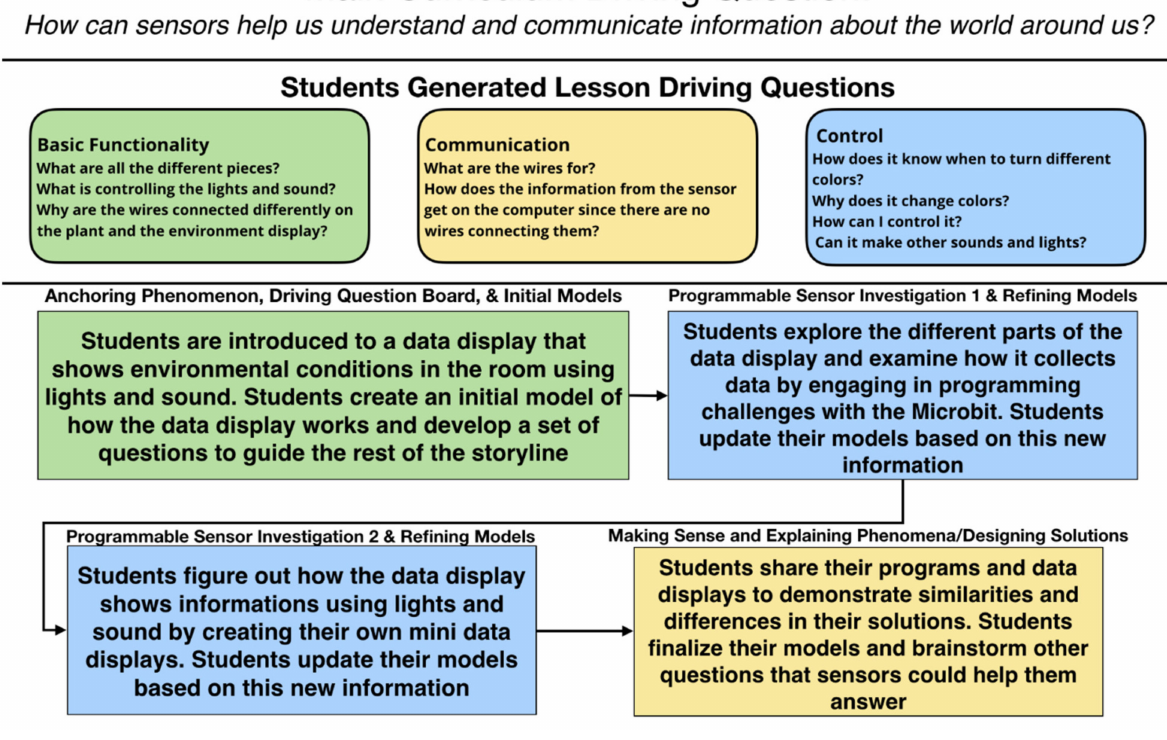
Figure 3. The overall flow of the Sensor Immersion